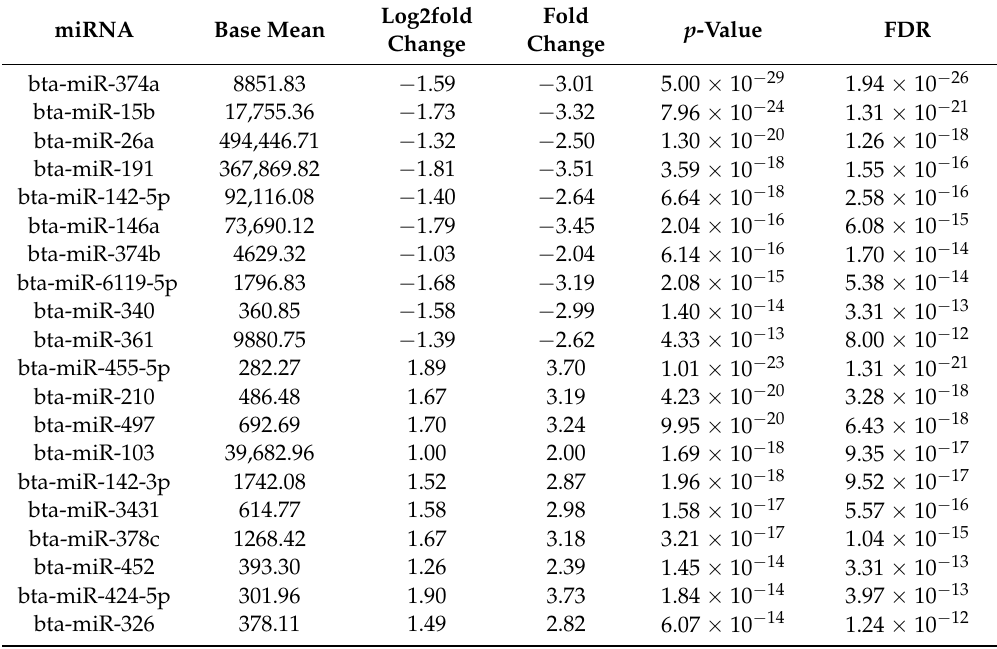
Figure 1. Volcano plot depicting miRNA differential expression results. Each dot represents a miRNA. Green and red dots represent miRNAs significantly differentially expressed at FDR < 0.05 and FDR < 1 × 10 11 , respectively. Black dots represent miRNAs that were not differentially expressed. Differential expression analysis was accomplished with DeSeq2. Table 4. The ten most up- and down-regulated miRNAs between D33 (pre-weaning) and D96